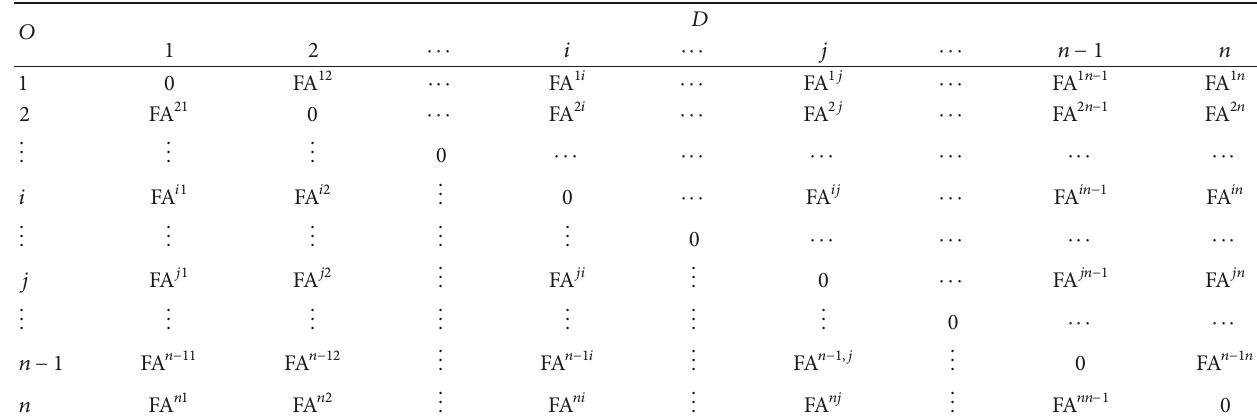
Table 1: A fare structure table for a bus